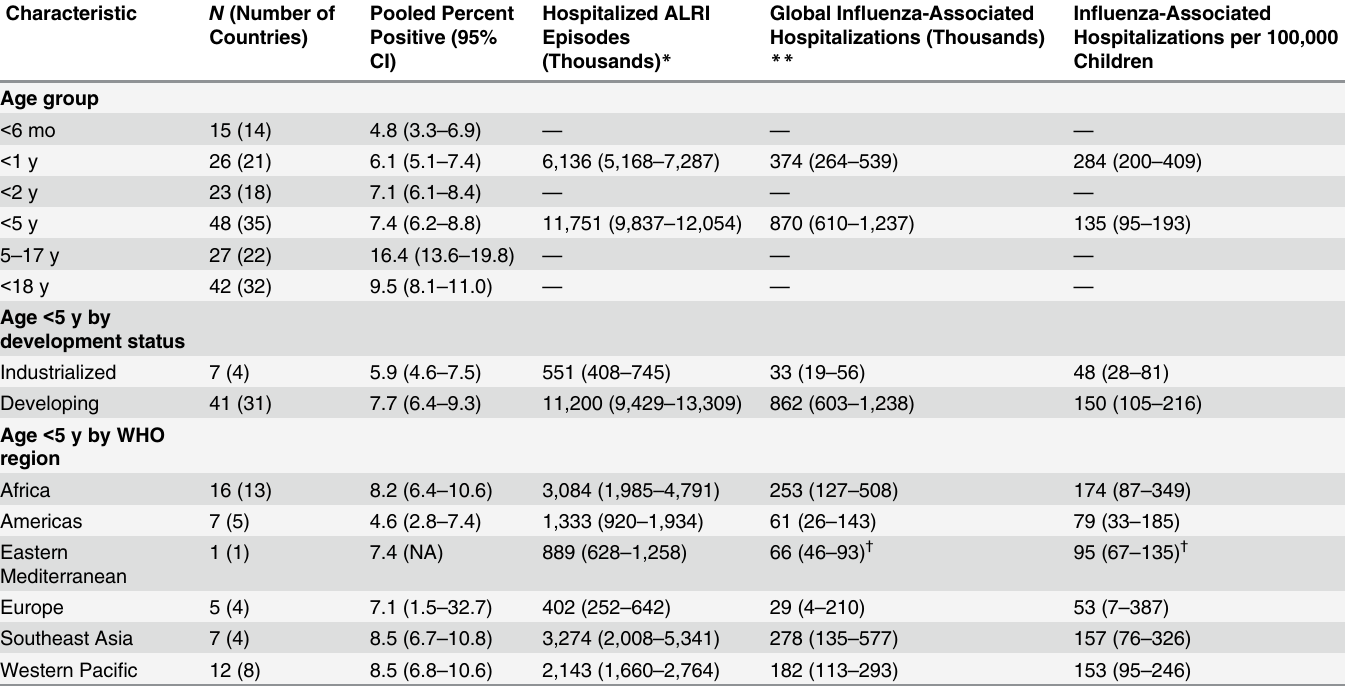
* Determined as described by Nair et al. [10] and adjusted for 2012 population. ** Point estimates and con fi dence intervals were calculated as products of point estimates, lower bounds, and upper bounds (respectively) of